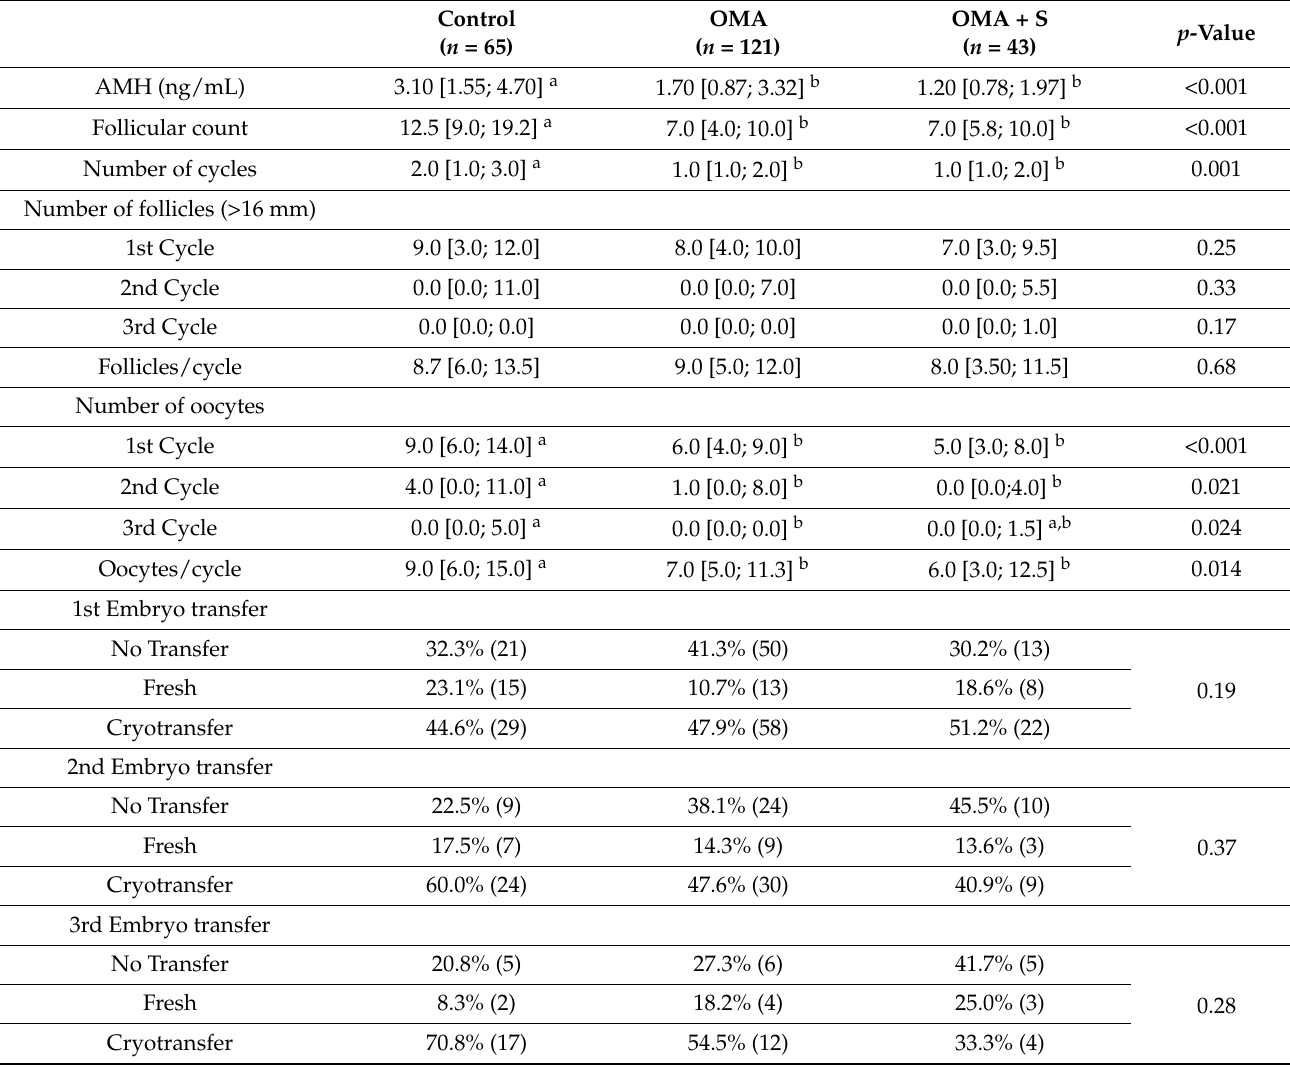
Table 2. Reproductive variables between women undergoing IVF with and without endometriosis.